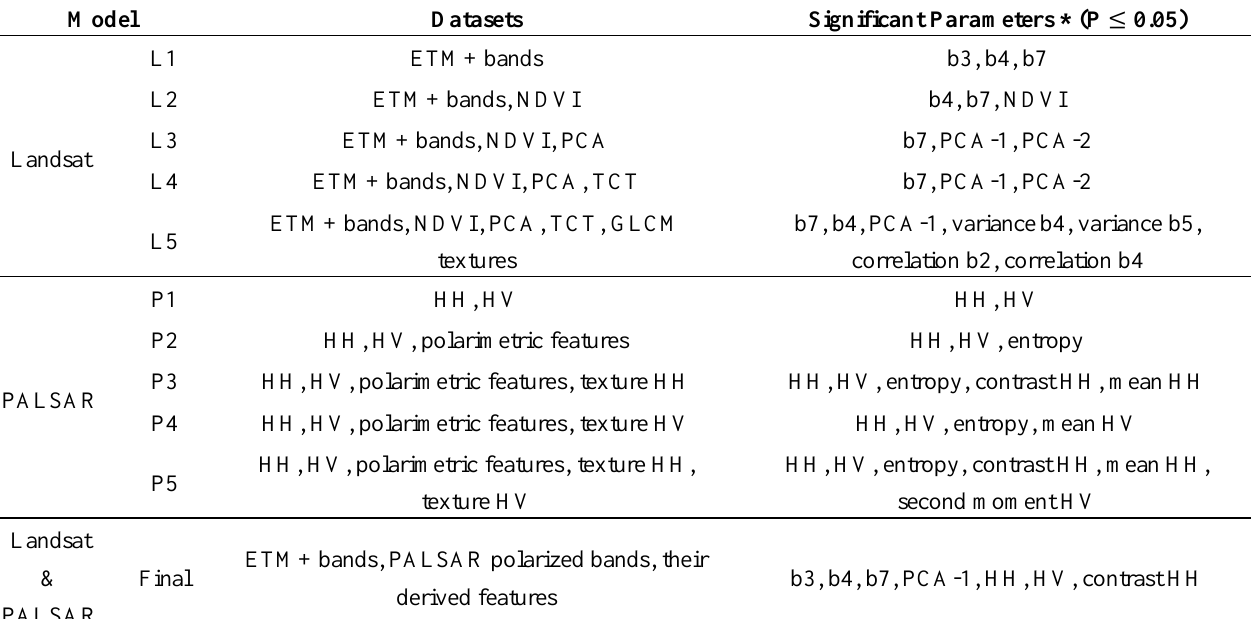
Table 4. Datasets and significant parameters for different AGB estimation